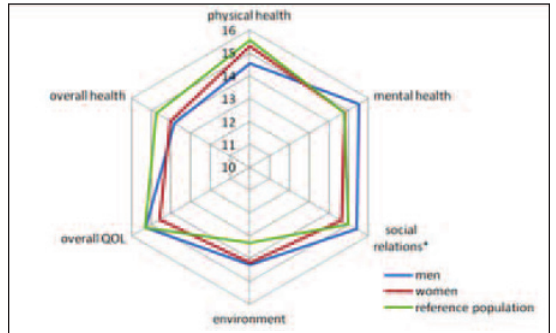
Figure 2. Comparison of score WHOQOL-BREF in morbidly obese patients before operation according to sex